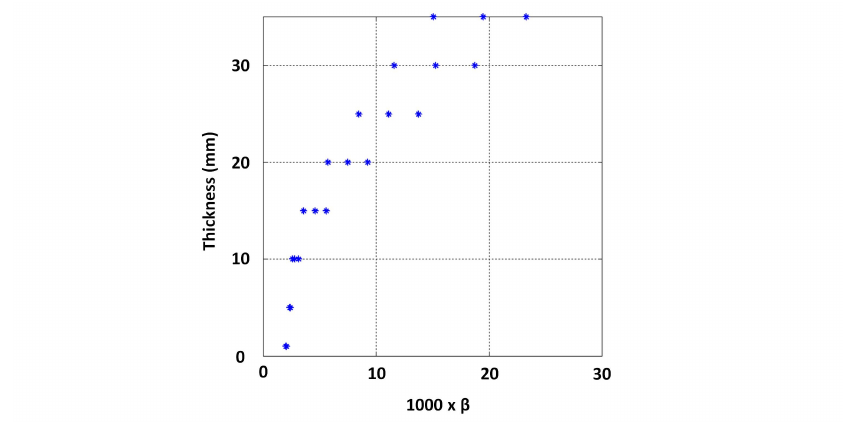
Figure 22. Effect of variation of σ on β .